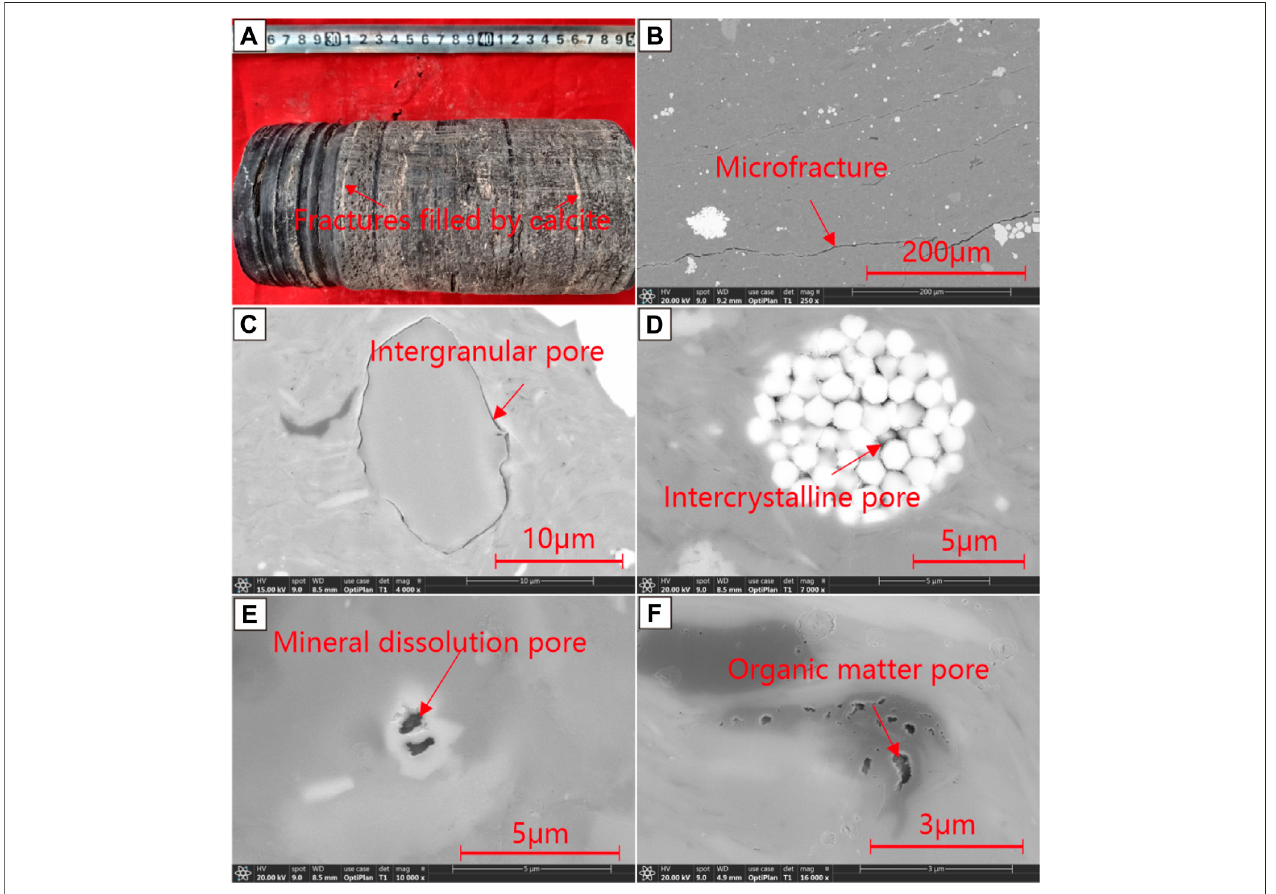
FIGURE6|(A) Fracturesare fi lledwithwhitecalcite (B) microfracture, (C) intergranularporebetweenlargeclayplatelets (D) triangularintercrystallineporeofpyrite, (E) mineral dissolution pore, and (F) irregular, bubble-like organic-matter pore in the black shale of the Dongyuemiao member.